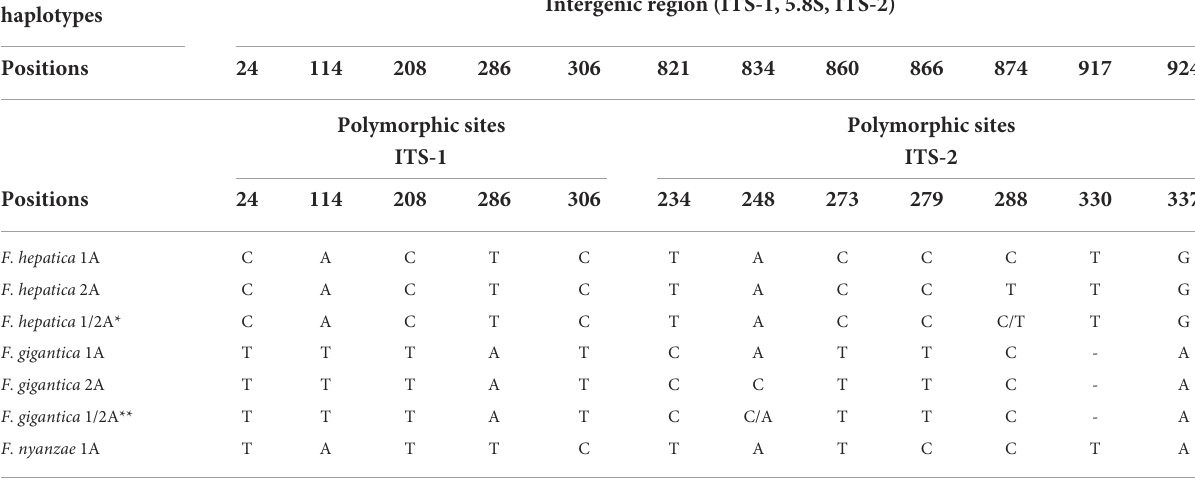
TABLE 2 Polymorphic sites in the sequence comparison of the nuclear rDNA complete intergenic region and in the ITS-1 and ITS-2 between haplotypes of “genetically pure” Fasciola hepatica from livestock in Europe and the Americas, haplotypes of “genetically pure” F. gigantica from livestock in African countries, and the haplotype of F. nyanzae from hippopotamuses in the nature reserves in South Africa. Fasciola spp. and